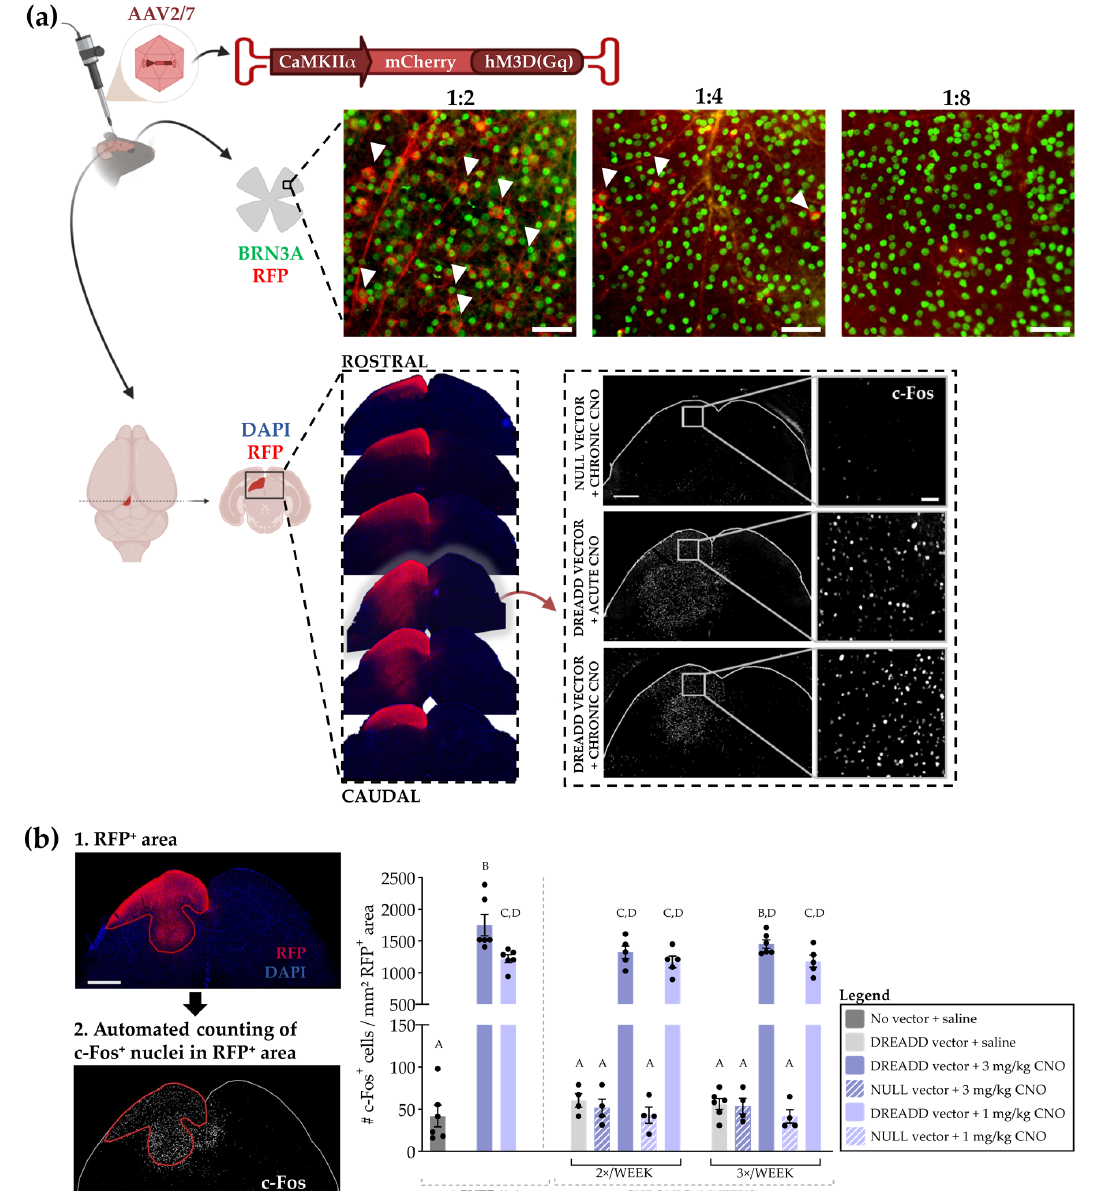
Figure 5. Optimization of the chronic DREADD toolbox in the retinocollicular system. ( a ) An hM3D(Gq) DREADD vector was unilaterally injected in the superior colliculus at a dilution series to exclude retrograde retinal transduction. Upon a dilution of 1:8, no transduction of RGCs was observed. For this dilution, representative images of the superior colliculus are shown, revealing a baseline c-Fos expression 2 h after CNO injection(s) upon null vector injection, versus a clear upregulation of c-Fos expression upon DREADD expression and CNO injection(s). Scale bar = 500 µ m and 50 µ m for magnified panels of the retina/superior colliculus. ( b ) Quantitative measurements of c-Fos + density confirmed this qualitative observation: repeated CNO injections still elicit an upregulation of c-Fos expression, identical to an acute injection, independent of the CNO (3 vs. 1 mg/kg bodyweight) concentration or stimulation scheme (single injection vs. two or three times per week for three consecutive weeks). Control conditions included naive, dark-adapted mice with saline stimulation (dark grey), mice transduced with DREADD vector and saline stimulations (light grey) and mice transduced with null vector together with repeated CNO injections (striped bars), all revealing baseline neuronal activity. Uppercase letters were used to indicate statistical significance, with different letters representing significant differences (two-way ANOVA, n = 4–6 mice, p ≤